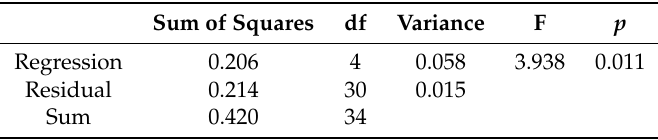
Table 6. The statistical parameters of variance